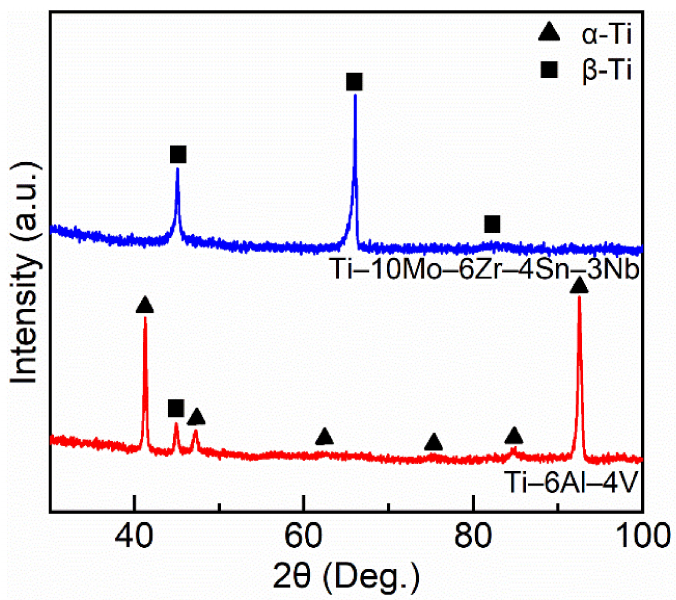
Figure 1. XRD patterns of Ti–10Mo–6Zr–4Sn–3Nb and Ti–6Al–4V samples.